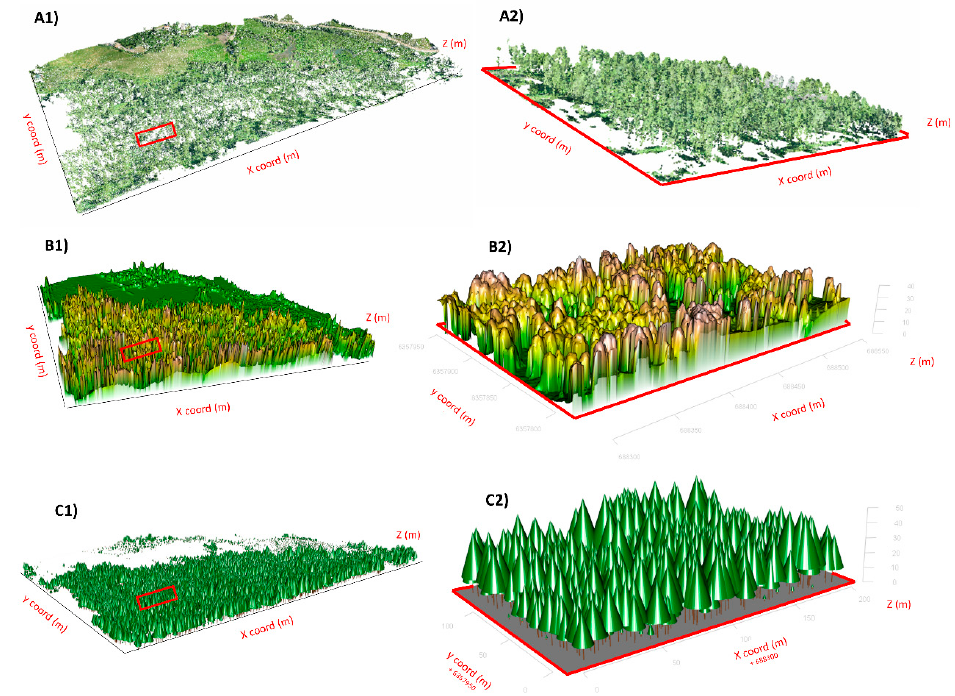
Figure 5. Illustration of individual tree detection at landscape ( A1 – C1 ) and plot ( A2 – C2 ) scales. ( A1,A2 ) UAV-point cloud; ( B1,B2 ) UAV-derived CHM; ( C1,C2 ) Virtual forest in 3D.